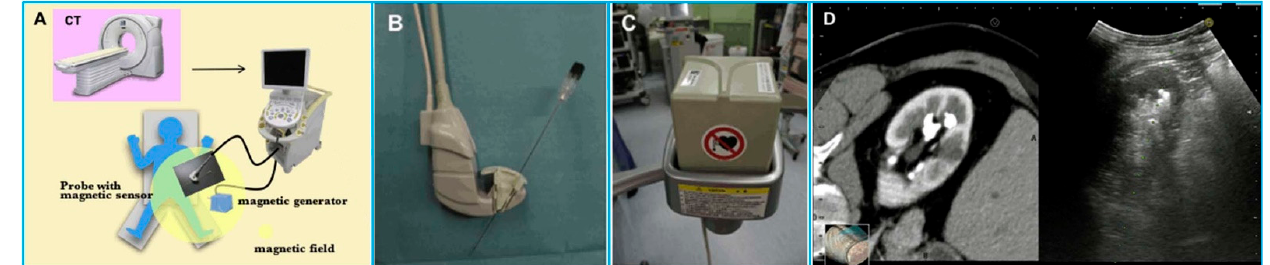
Figure 16. A navigation system for percutaneous renal puncture. ( A ) The main components of the system; ( B ) The magnetic sensor attached to an US probe; ( C ) The magnetic field generator; ( D ) US image and CT volume data displaying side by side on the same monitor. Reprinted from [175] with permission.